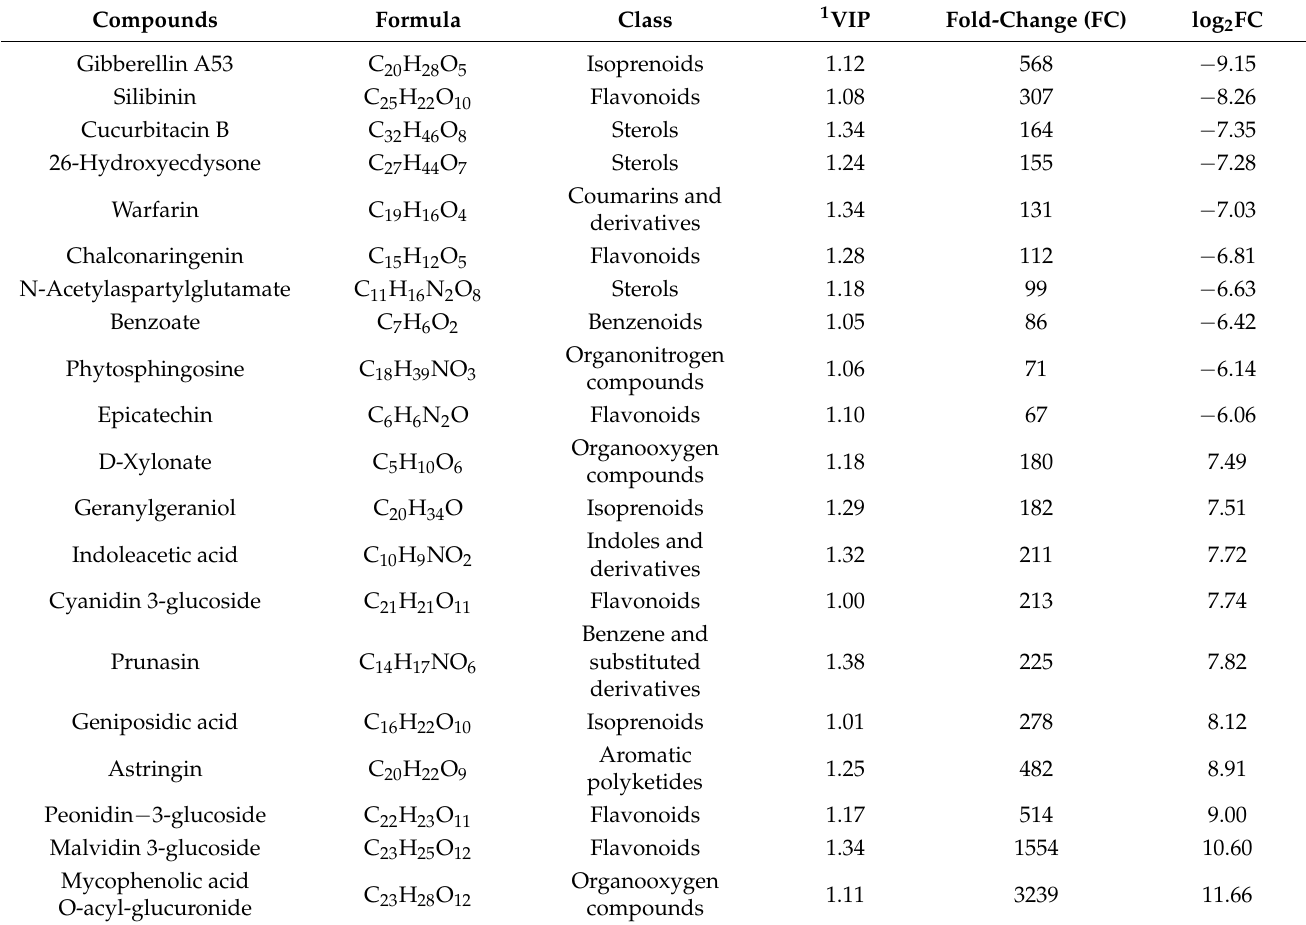
Table 1. Top 20 significantly different metabolites between the bark and leaves of H. chrysantha